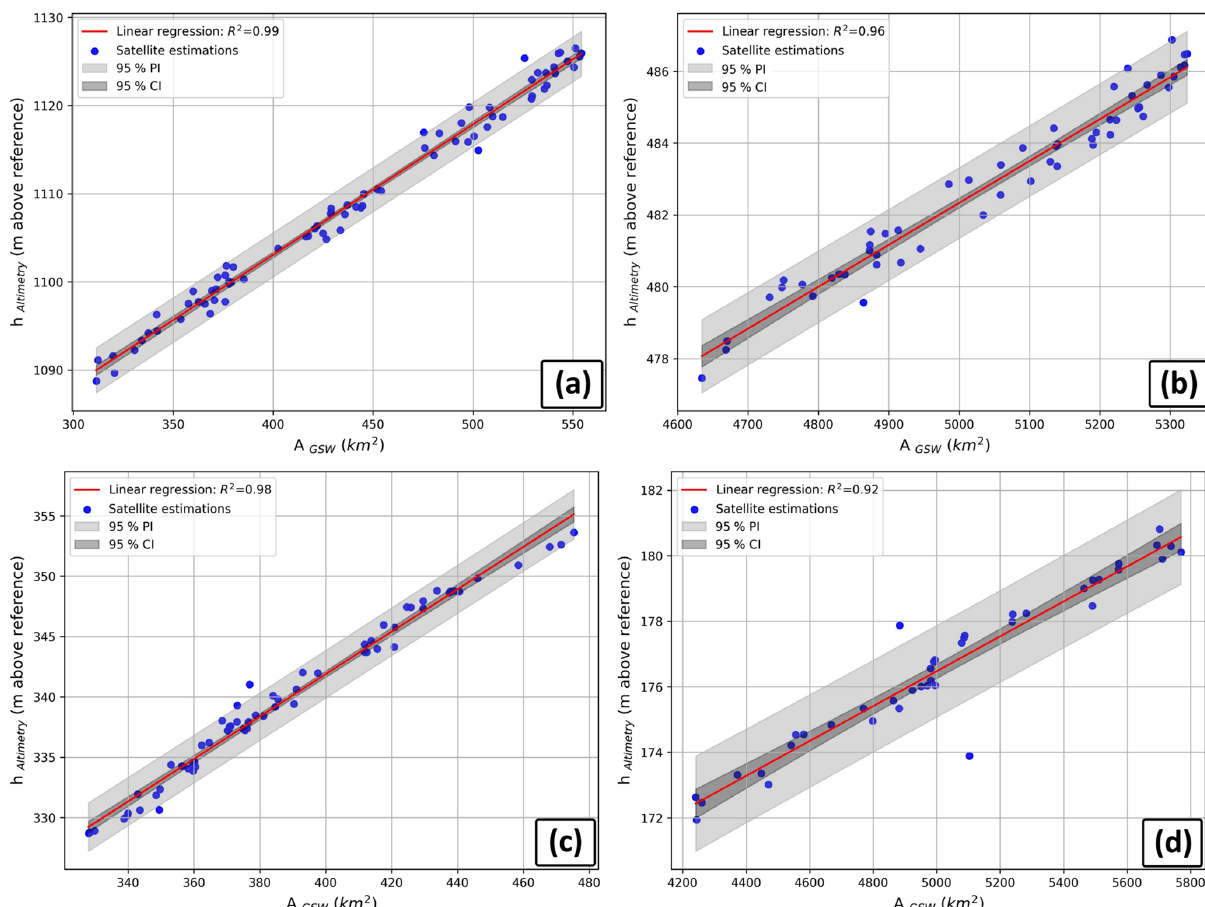
Figure 4. Area–level regressions for Lake Powell (a) , Kariba (b) , Mead (c) and Nasser (d) , with R 2 values of 0.99, 0.96, 0.98 and 0.92